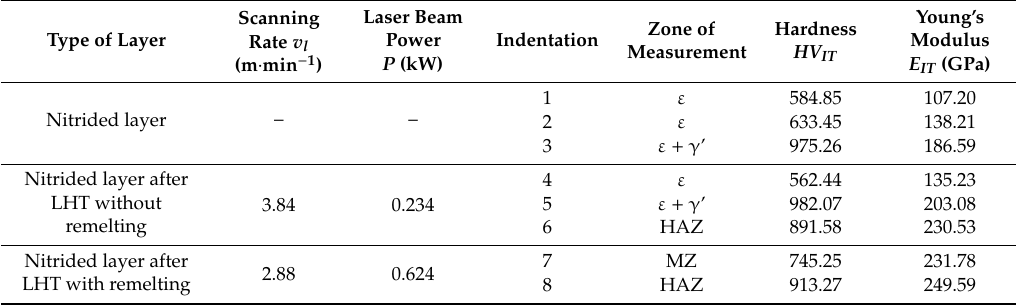
Table 3. Some measured HV IT and E IT values in gas-nitrided layer and gas-nitrided layer after LHT with or without